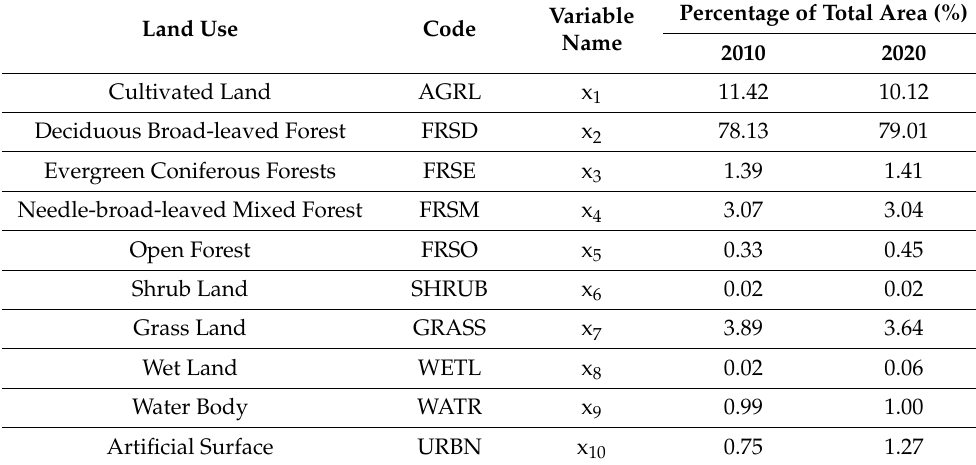
Table 1. Land use change of the research area from 2010 to 2020. Land Use